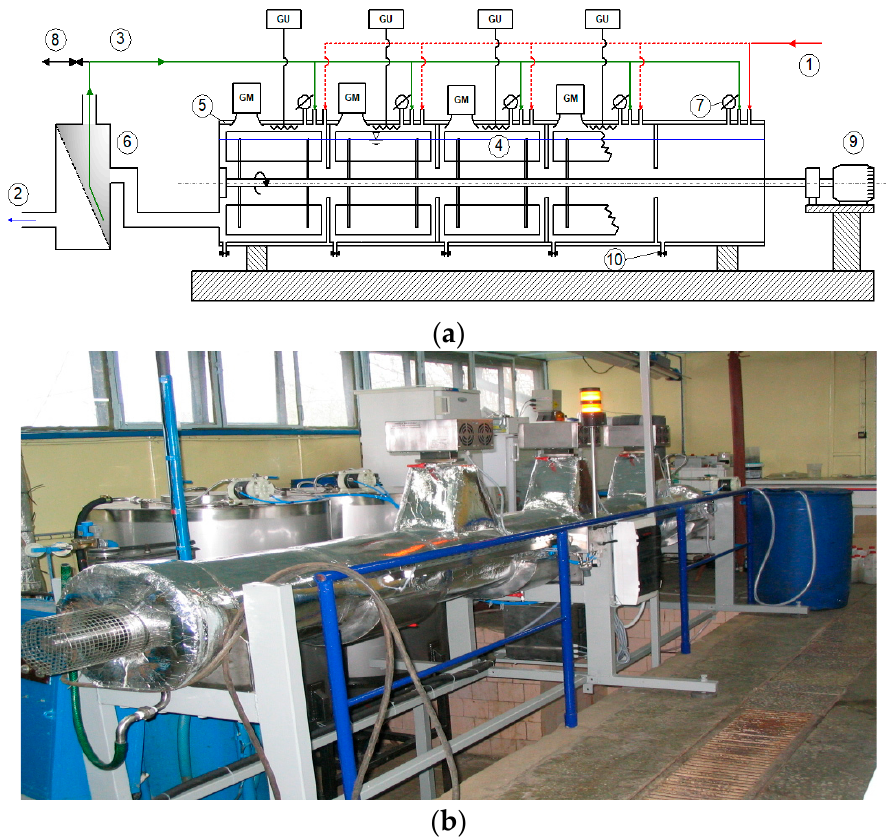
Figure 1. Horizontal flow anaerobic reactor (HFAR) ( a ) schematic diagram, ( b ) photo. 1—influent; 2—effluent; 3—sludge recirculation; 4—mixing blade; 5—thermal insulation; 6—membrane module; 7—gas meter; 8—digestate; 9—gearmotor; 10—sampling port; GM—microwave generator; GU—ultrasonic generator.